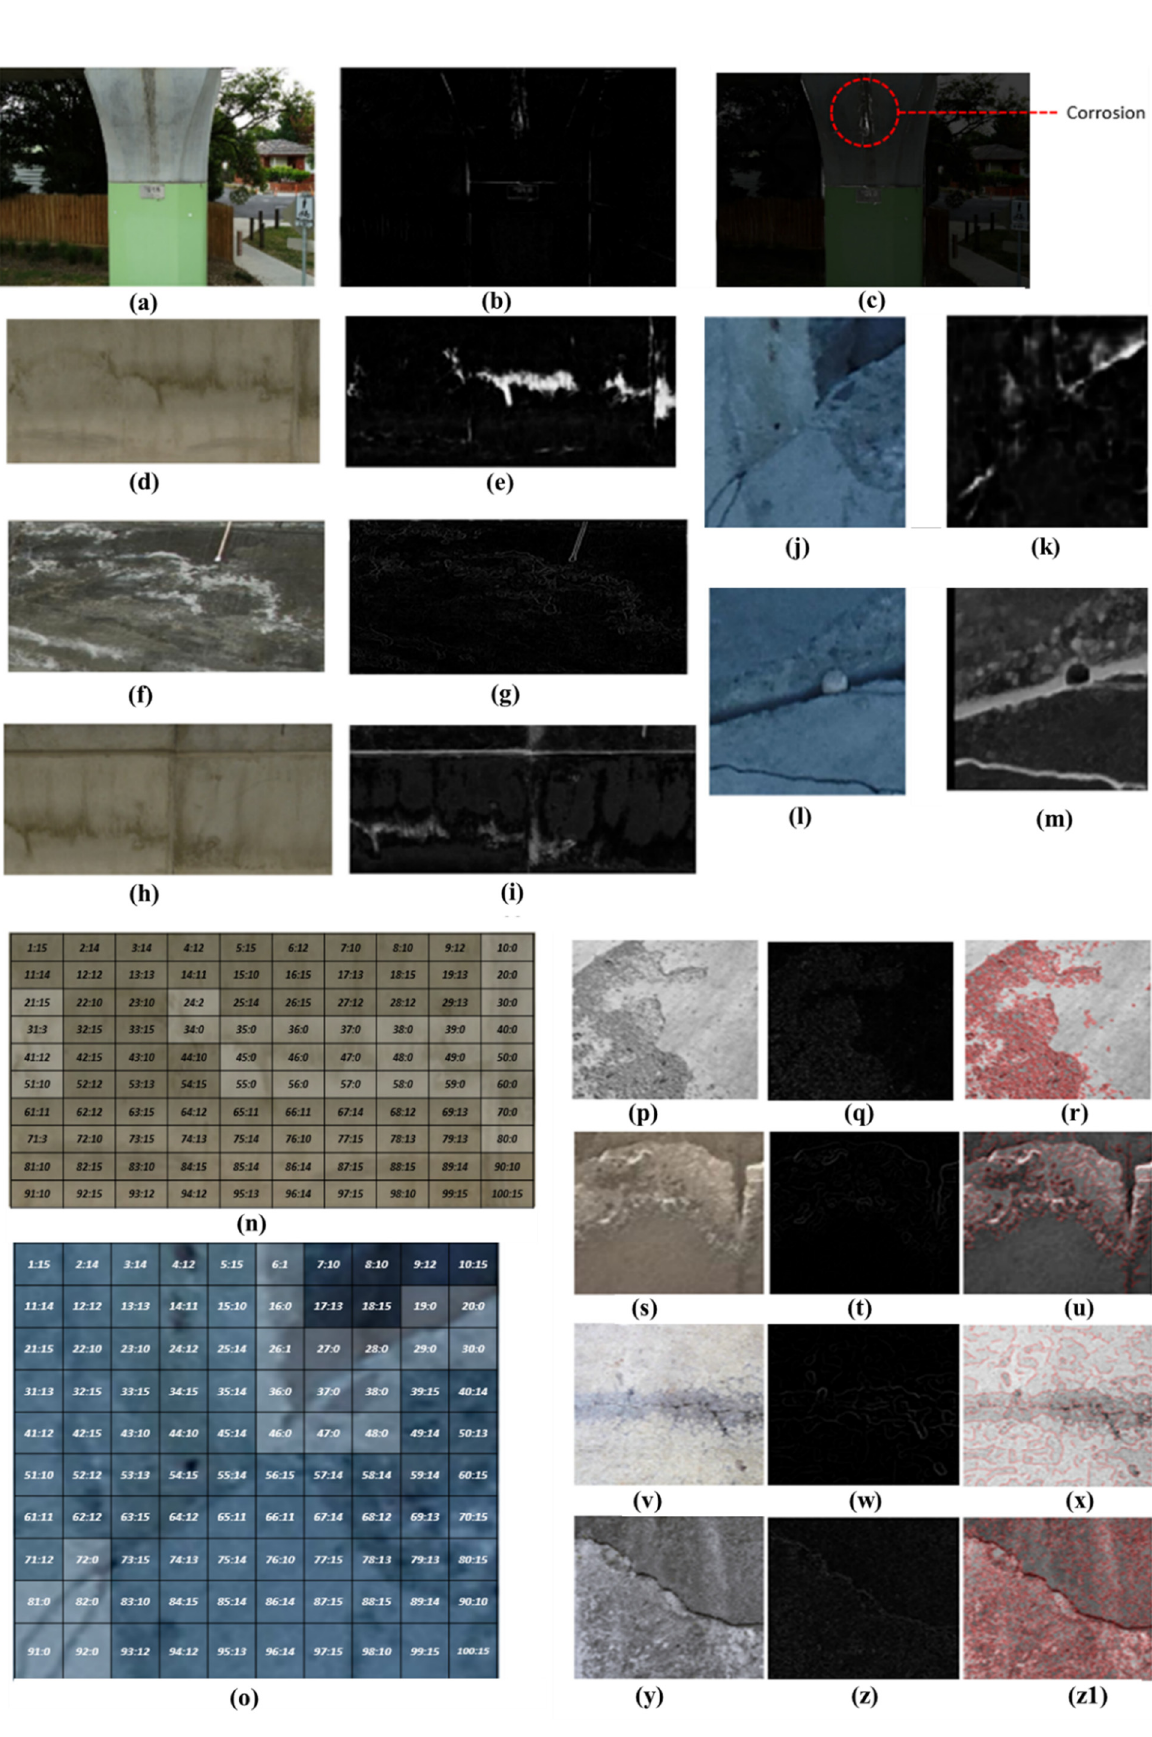
Figure 11. ( a – z1 ) Results of several samples with corrosion and water straining.